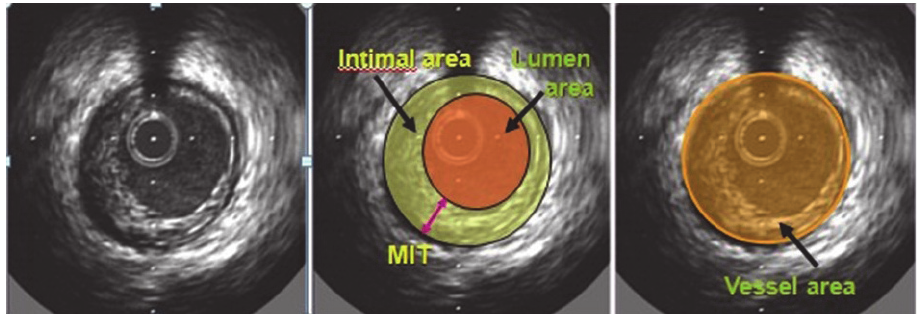
Fig. 1. Basic parameters of IVUS examination interpretation MIT = maximal intimal thickness Vessel area = lumen area + intimal area Percent area stenosis = (intimal area / vessel area) ×